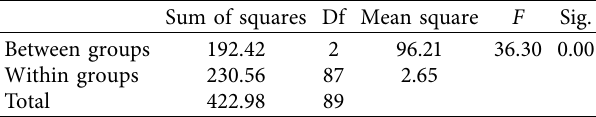
Table 4: Inferential statistics of reading comprehension